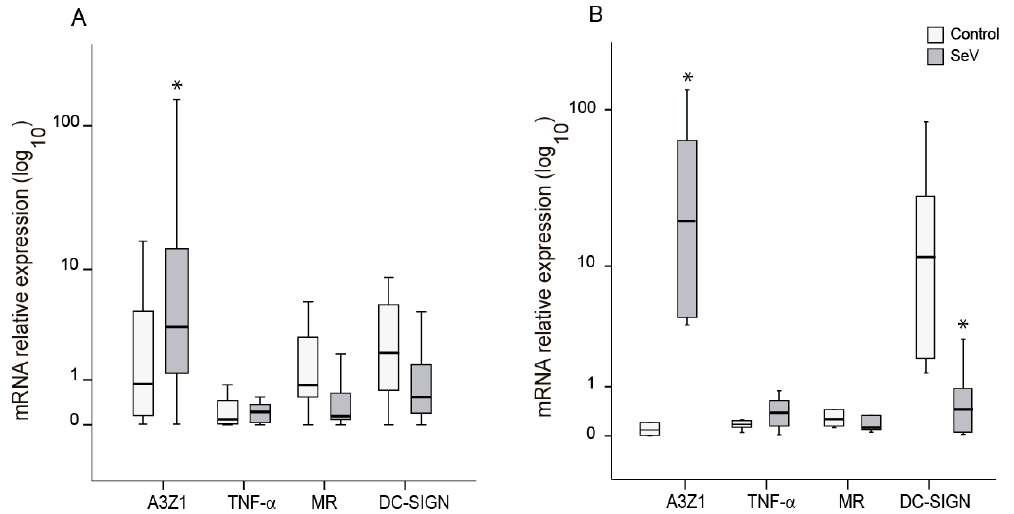
Figure 2. Differentiation markers in ovine myeloid cells infected with Sendai virus (SeV). Relative expression of M1 (A3Z1, TNF- α ) and M2 (MR, DC-SIGN) differentiation markers measured in alveolar macrophages ( A ) and blood derived macrophages ( B ). Values are the median (±interquartile range) of at least three independent experiments. * p < 0.05 (paired Mann–Whitney U Test).